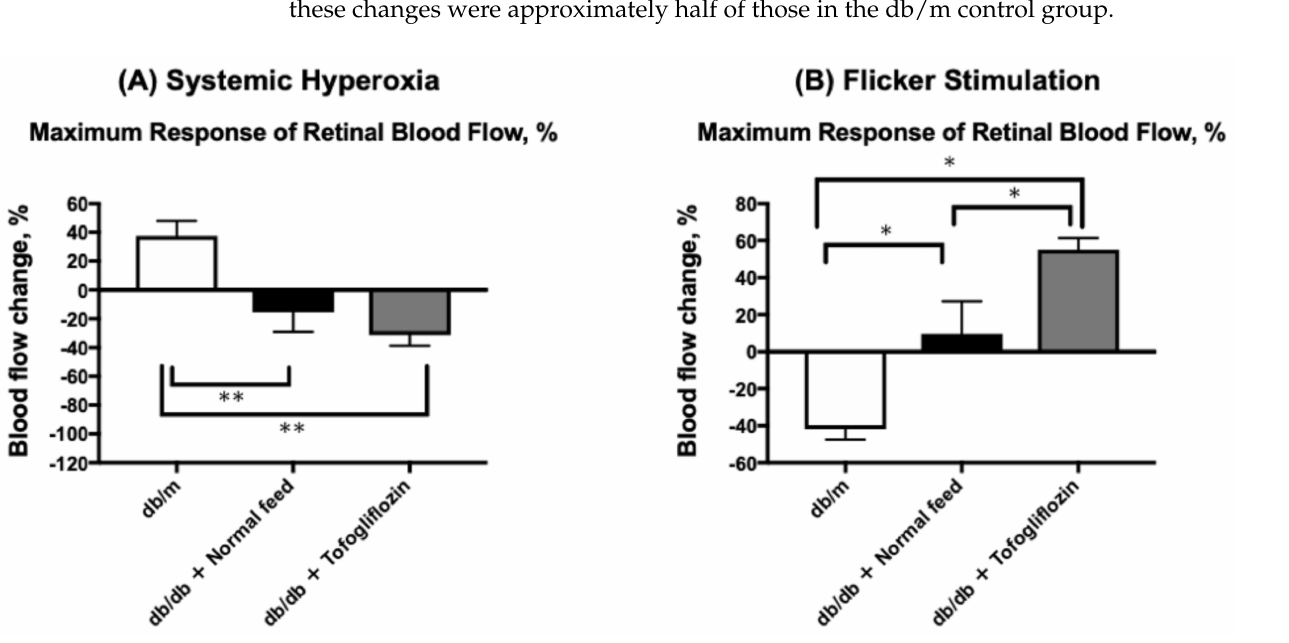
Figure 6. Maximal changes in RBF from baseline in response to hyperoxia ( A ) and flicker stimulation ( B ) in 14-week-old mice of db/m ( n = 5) as a non-diabetic control and untreated db/db mice ( n = 6) and tofogliflozin-treated diabetic mice ( n = 6). * p < 0.05, ** p < 0.01 compared with db/m by a one-way ANOVA followed by Holm-Sidak